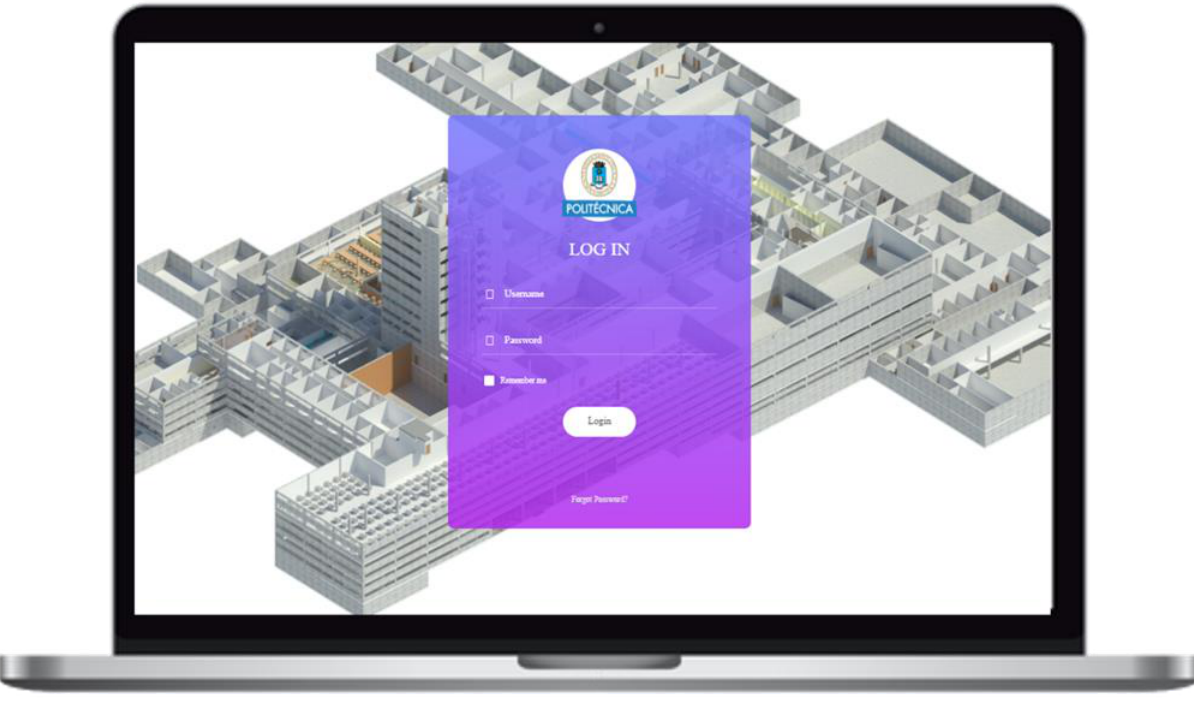
Figure 10. Intelligent platform login.